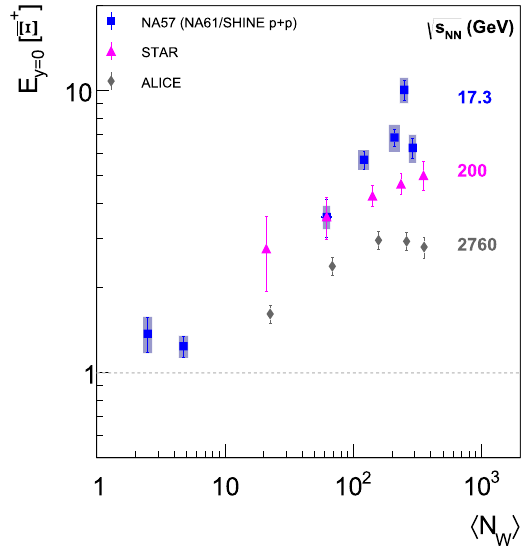
Fig. 7 The strangeness enhancement E at the mid-rapidity as a func- tion of average number of wounded nucleons (cid:3) N W (cid:4) calculated as a ratio of rapidity density for (cid:2) − production ( left ) and (cid:2) + production ( right ) in nucleus–nucleus interactions per (cid:3) N W (cid:4) divided by the corresponding value for p+p interactions (see Eq. 4). Red circles – NA49 Pb+Pb at